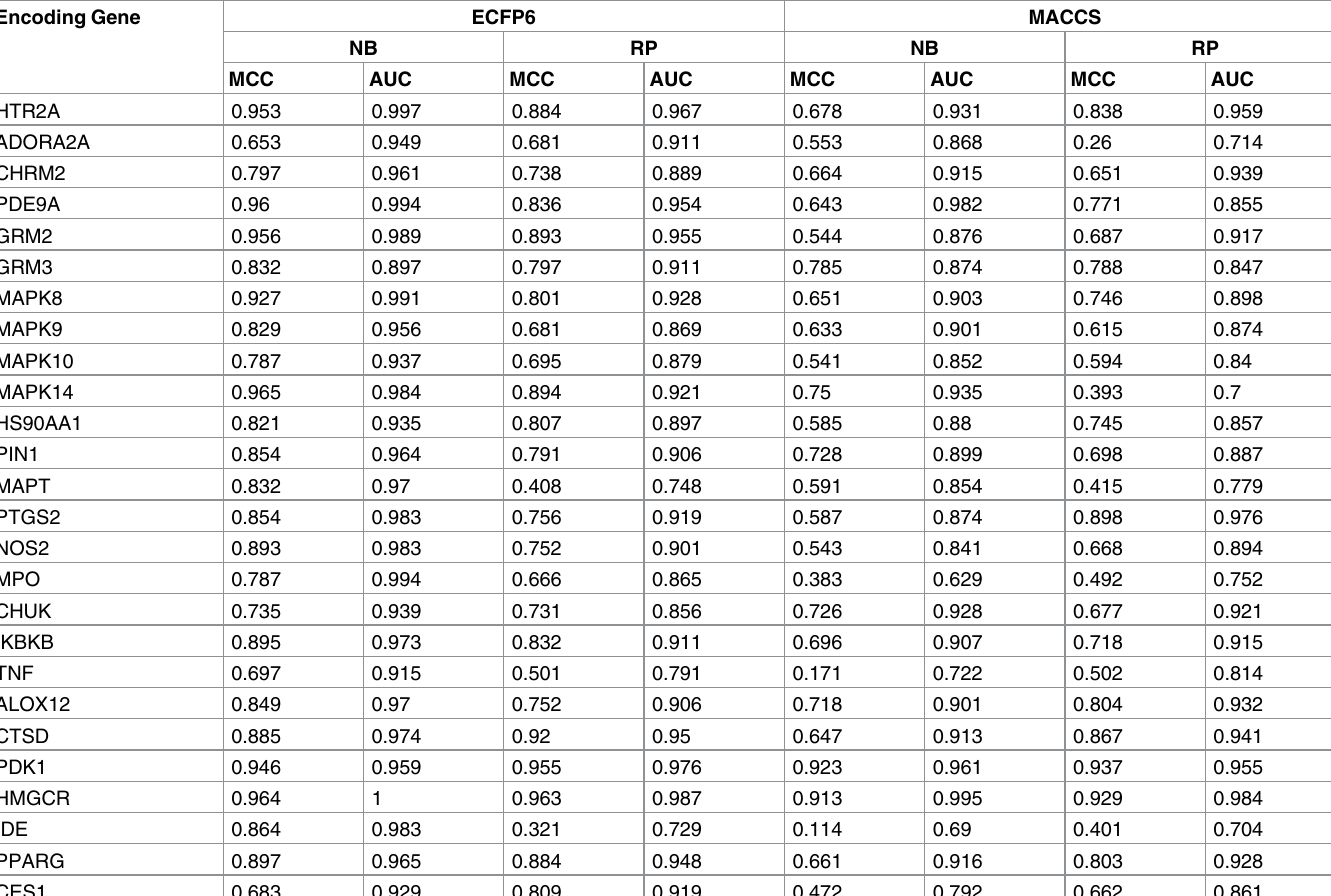
Table 3. Performanceof the test set validation for 25 targets towards Alzheimer disease using NB and RP classifiers. Encoding Gene